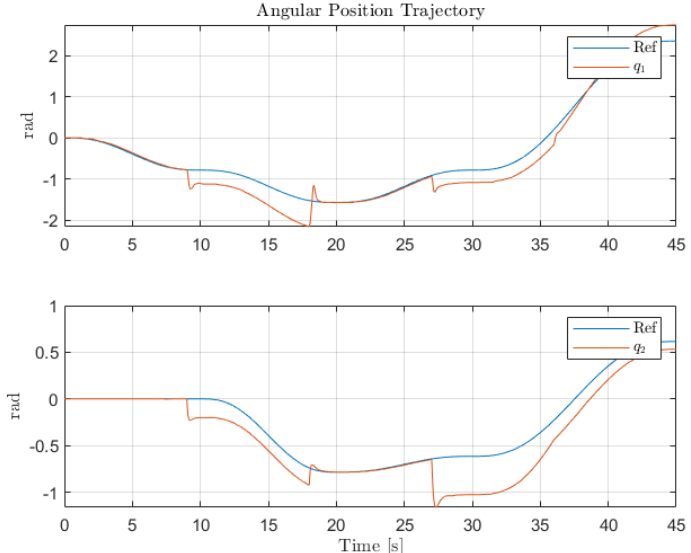
Figure 15. Individual trajectories for q i of Links 1 and